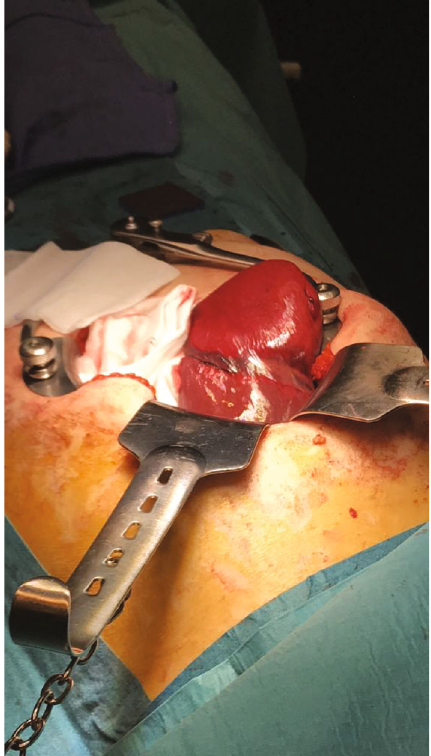
Figure 3: Preoperative view showing the hernia tightening ring on the left liver lobe.